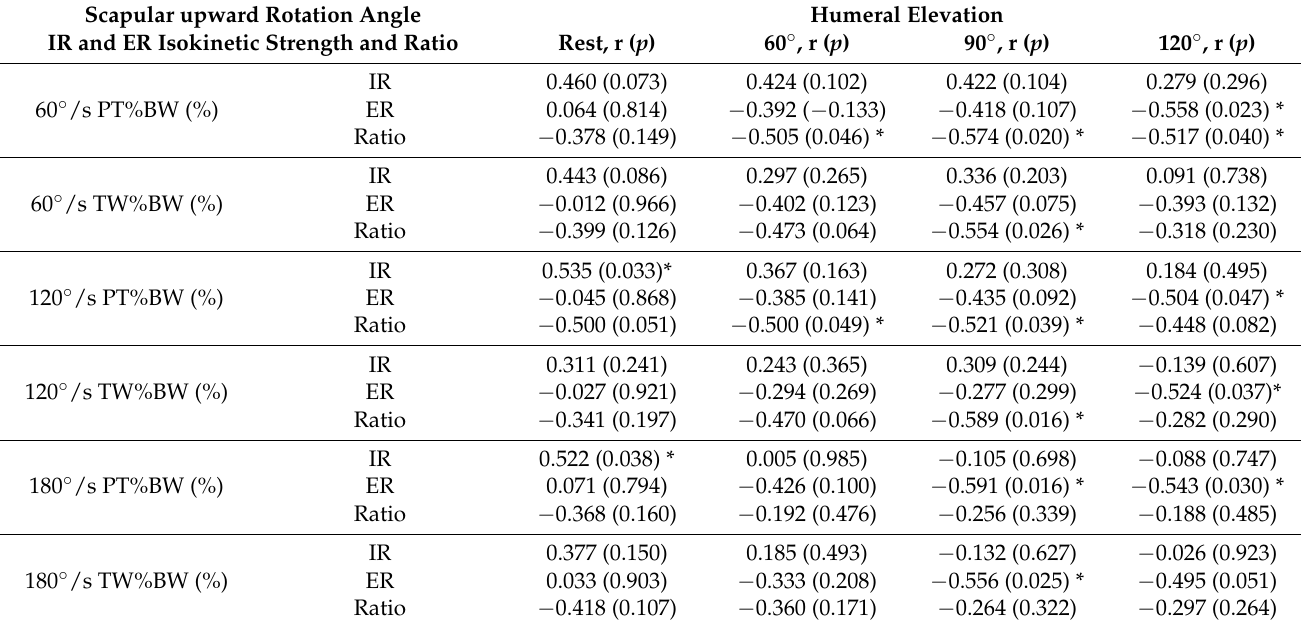
Table 2. The relationship between scapular upward rotation ( ◦ ) and shoulder isokinetic strength. Scapular upward Rotation Angle